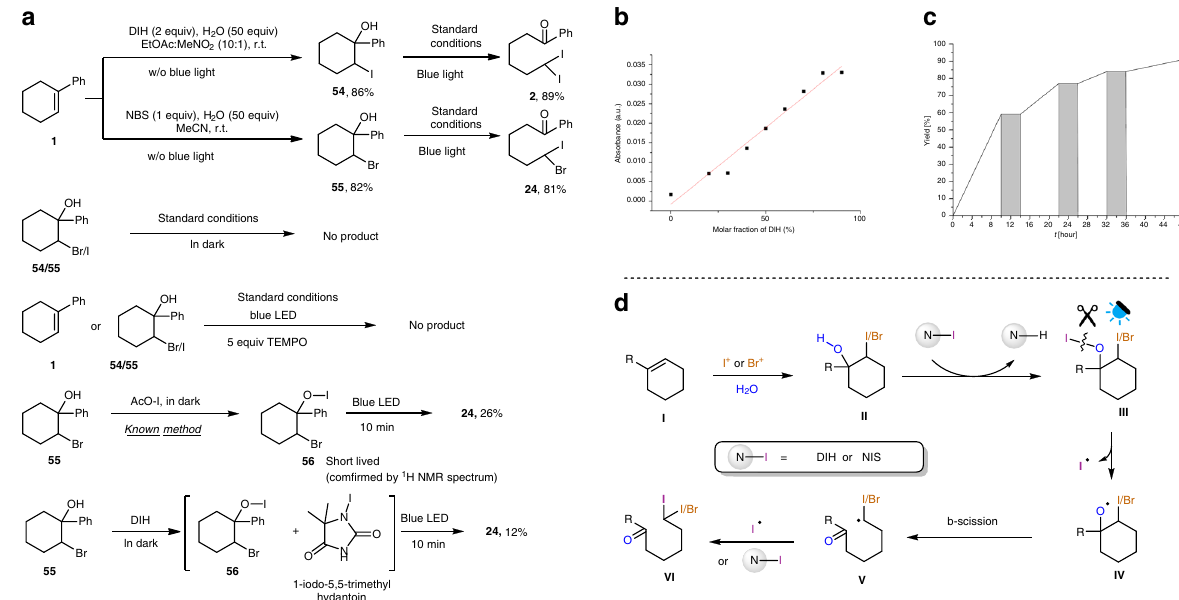
Fig. 5 Plausible mechanism with supporting evidence. a Control experiments. b UV-Vis measurements of stoichiometry between 55 and DIH @ 450 nm. c Light on-off experiments of deconstructive geminal diiodination of 1 . d Plausible mechanism.